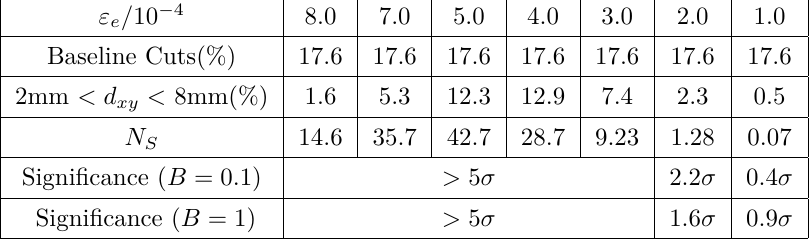
Table 6 . The same as table 5, but using the e + e − channel.